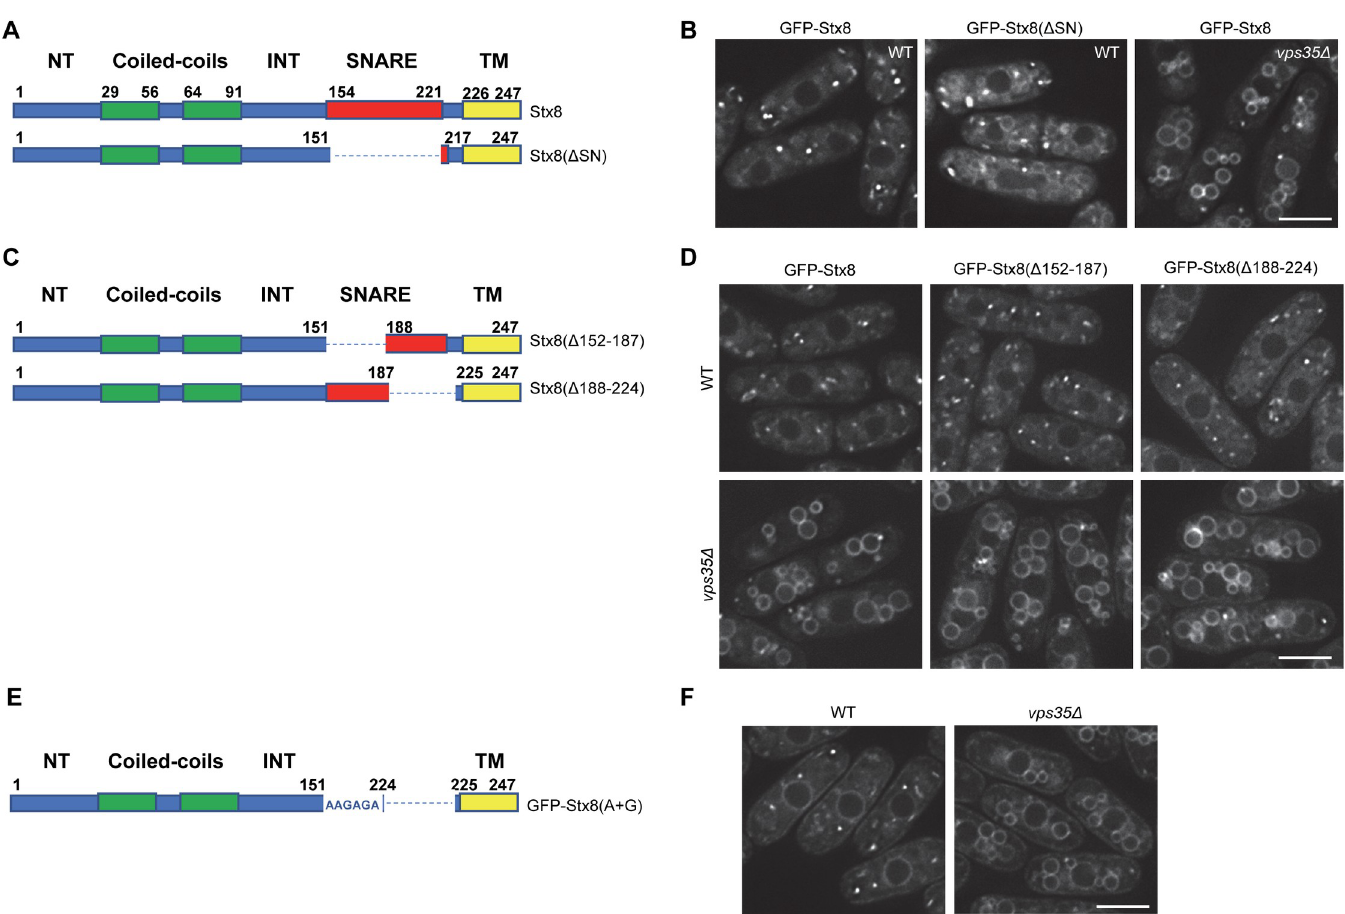
Fig 7. Contribution of the SNARE domain to Stx8 recycling. (A) Schematic, not-to-scale representation of Stx8 and Stx8( Δ SN), lacking the SNARE domain. (B) Distribution of Stx8 and Stx8( Δ SN). (C) Schematic, not-to-scale representation of Stx8( Δ 152–187) and Stx8( Δ 188–224) variants, lacking the residues indicated in parentheses. (D) Distribution of the indicated Stx8 variants in wild type (WT) and vps35 Δ cells. (E) Schematic, not-to-scale representation of Stx8(A+G), where residues 152–223 were changed to a string of alanine and glycine residues. (F) Distribution of Stx8(A+G) in WT and vps35 Δ cells. In all the protein representations, bold numbers denote the initial and terminal amino acidic position of the regions of interest, and the dashed lines represent the protein region missing in the corresponding variant. Images are single planes captured with a DeltaVision system. Scale bar, 5 μ m.